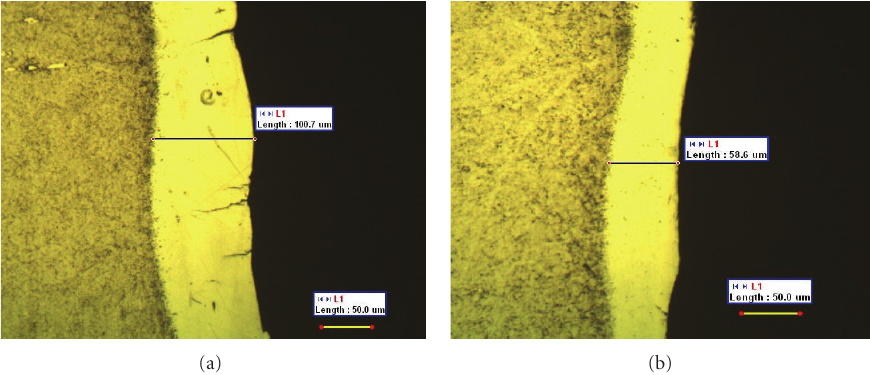
Figure 6: Surface layer microstructure after the: (a) EDM U = 80(V), I = 48(A), Ti = 400 ( μ s), (b) EDM U = 80 (V), I = 48 (A), Ti = 400 ( μ s), Tp = 50( μ s) and roto-peen n = 5000 (rev/min), t =